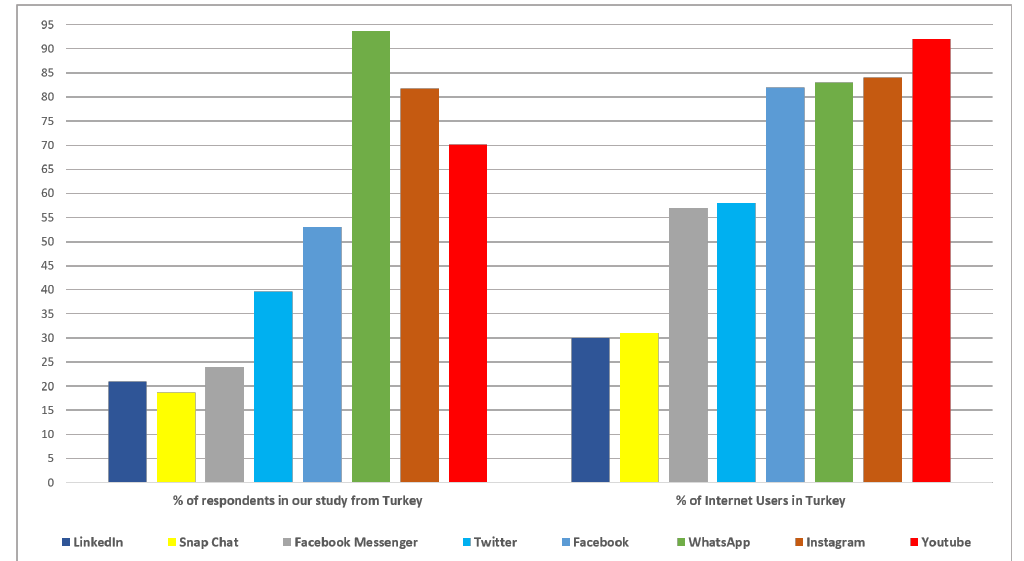
Figure 2. Percentage of users active on various social media